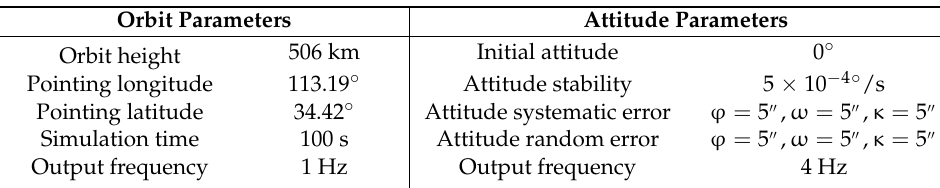
Table 1. Orbit and attitude parameters.